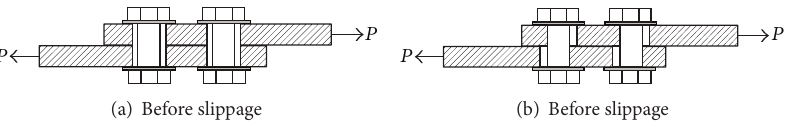
Figure 1: Bolted joint slippage effects.